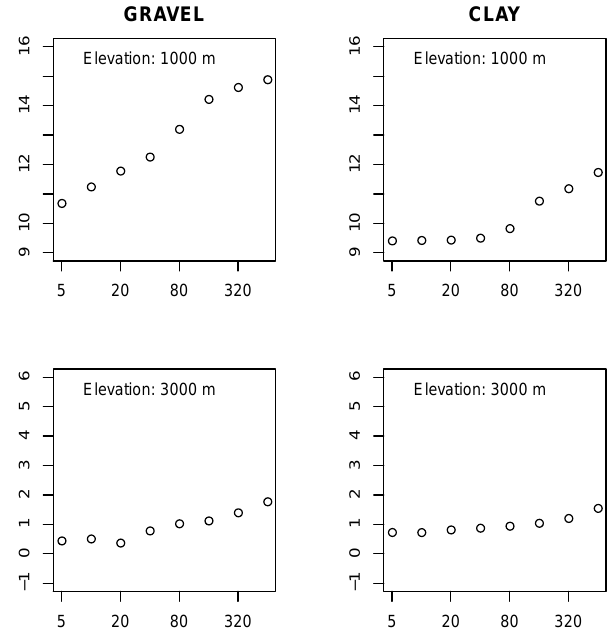
Fig. 6. Sensitivities of MAGT modeled at 10cm depth to the thick- ness of the first ground layer for gravel (left) and clay (right). Mod- eled MAGT in gravel increase linearly for increasing ground thick- ness (note the logarithmic x axis), while MAGT in clay are constant for dz min ≤ 20mm. The sensitivity to dz min decreases for ground temperatures closer to 0 ◦ C (bottom